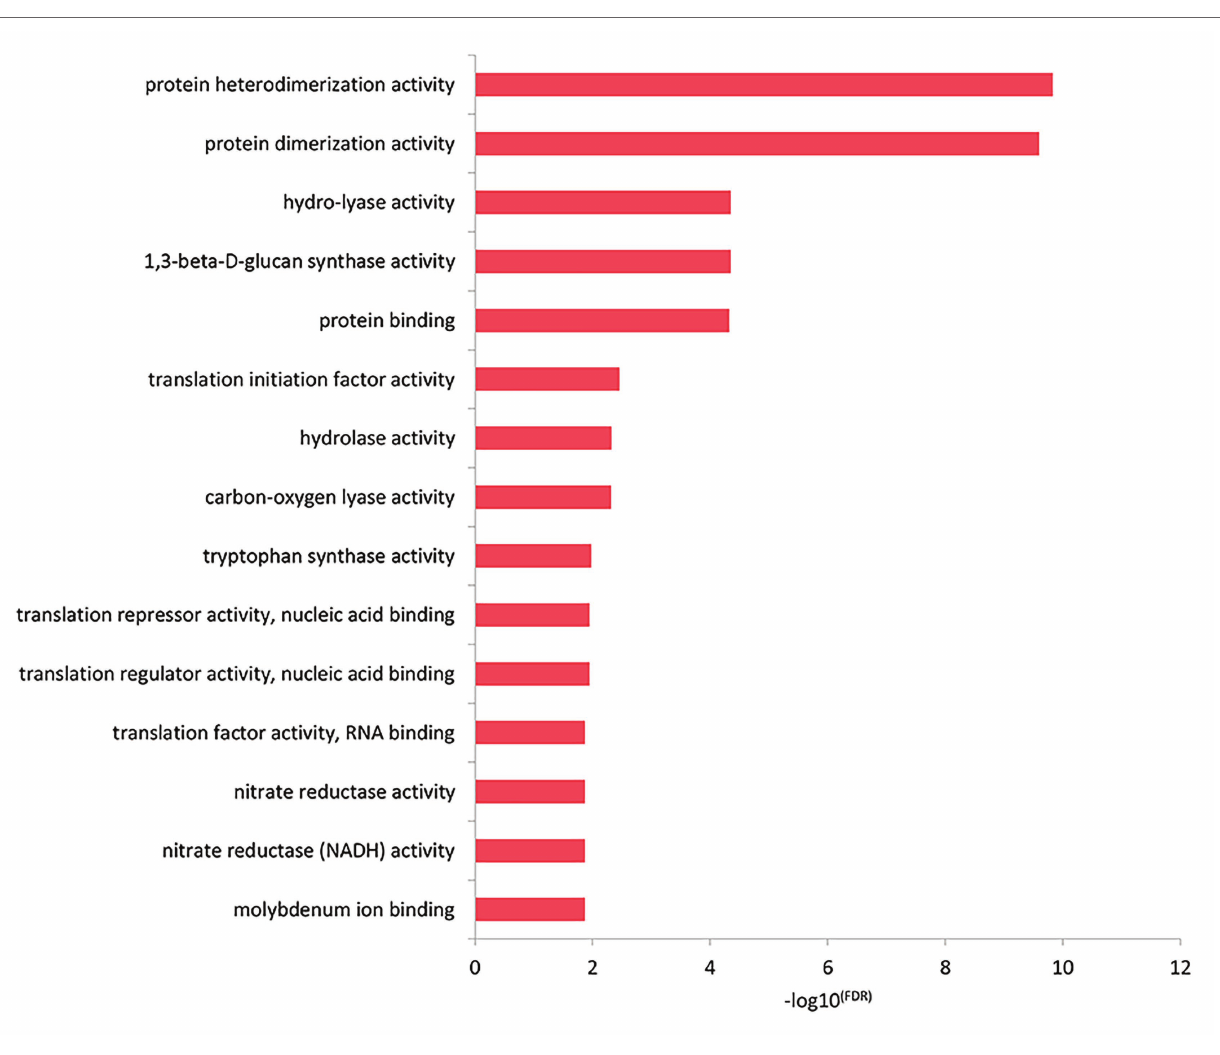
FIGURE 4 | Molecular function enrichment analysis of differentially expressed genes in the top GO